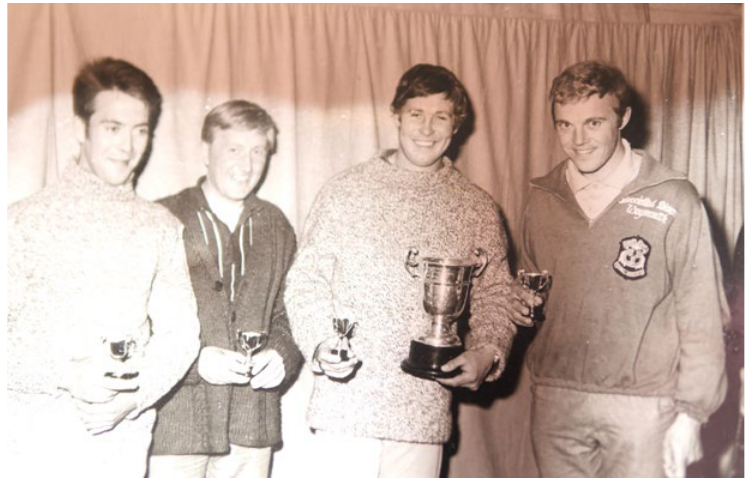
Figure 5.1 Colin House with his spearfishing team, The Weymouth Congas, in 1960. Colin is on the far